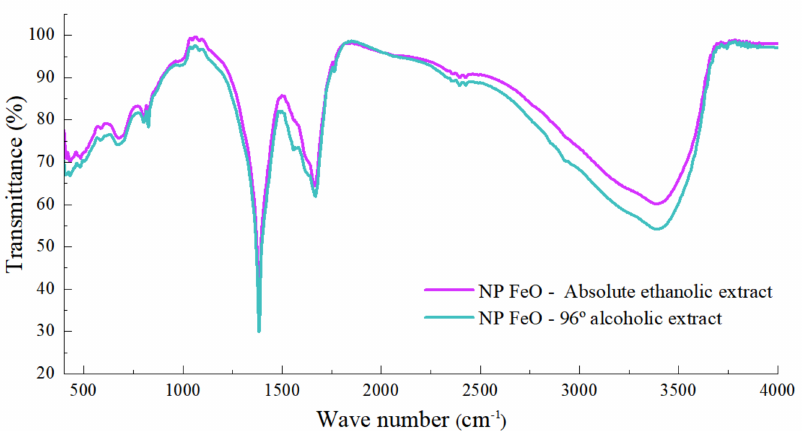
Figure 4. FT-IR characterization of FeO NPs colloids, mediated by E. globulus extract, using the 96% alcohol solvent and absolute ethanol